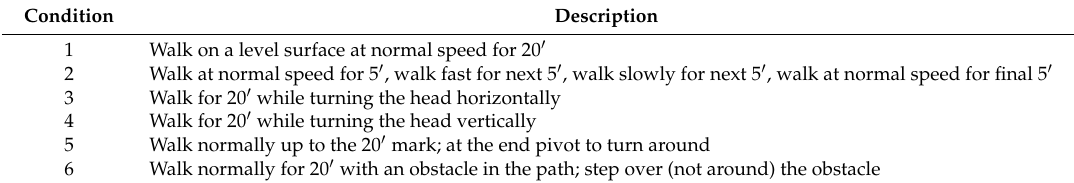
Figure 1. A diagram of the wireless gait analysis sensor is shown with dimensions and the axis orientation. The sensor is worn by subjects on the back at the T4 level. Table 2. Conditions of dynamic gait index (DGI) movements